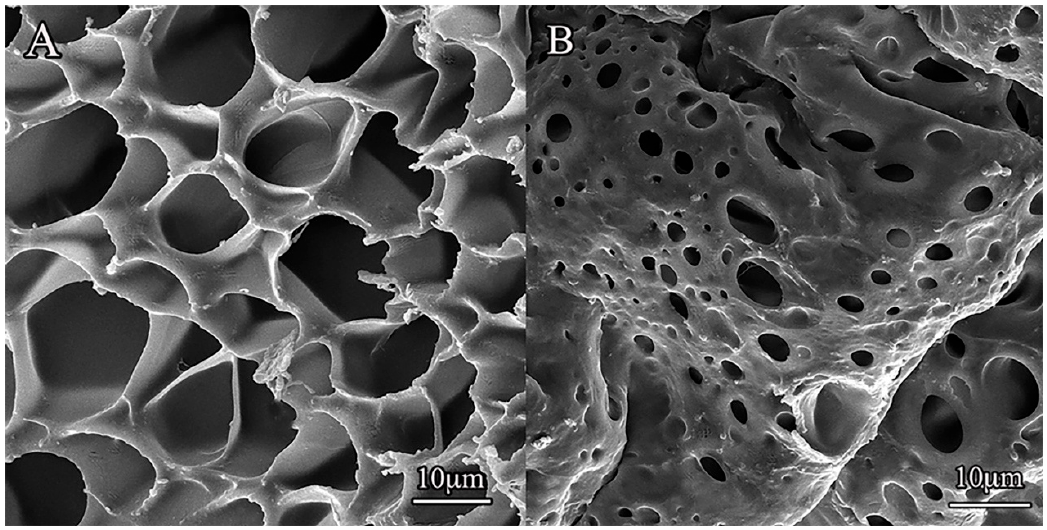
Figure 3. SEM photographs of lyophilized PU ( A ) and TA10-PU(S) ( B ) hydrogels.